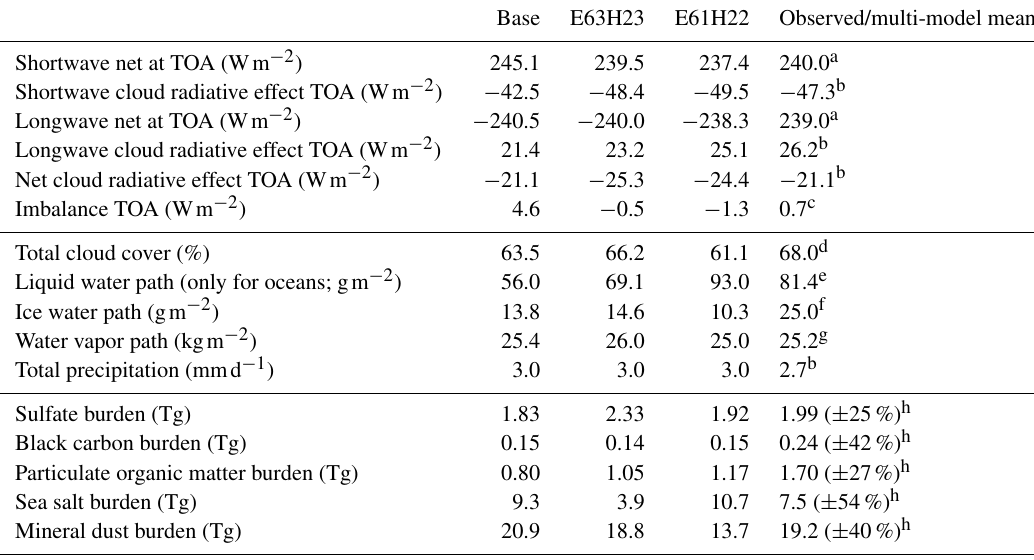
Table 8. Global annual mean top of the atmosphere (TOA) energy budget, cloud-related properties, and aerosol mass burdens of the ECHAM- HAMMOZ base simulation, the ECHAM6.3-HAM2.1 (E63H23) and ECHAM6.1-HAM2.2 (E61H22) climate simulations of Tegen et al. (2018), and observations or multi-model mean values.